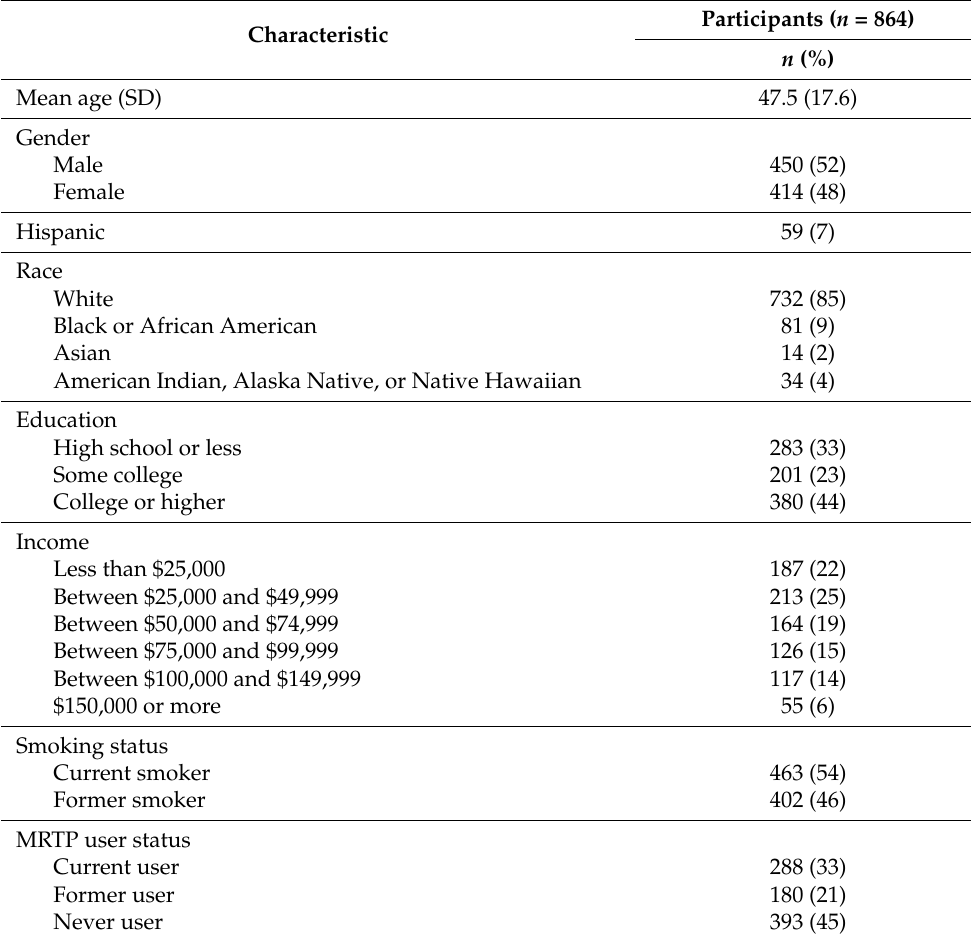
Table 1. Participant